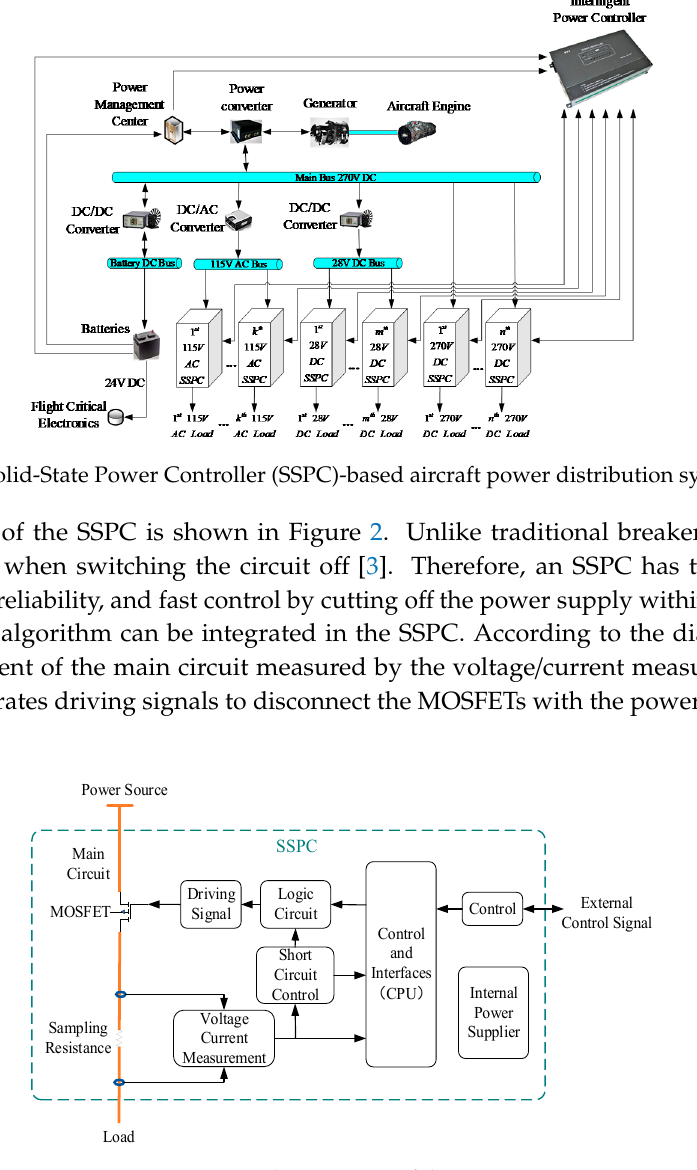
Figure 2. The structure of the SSPC.